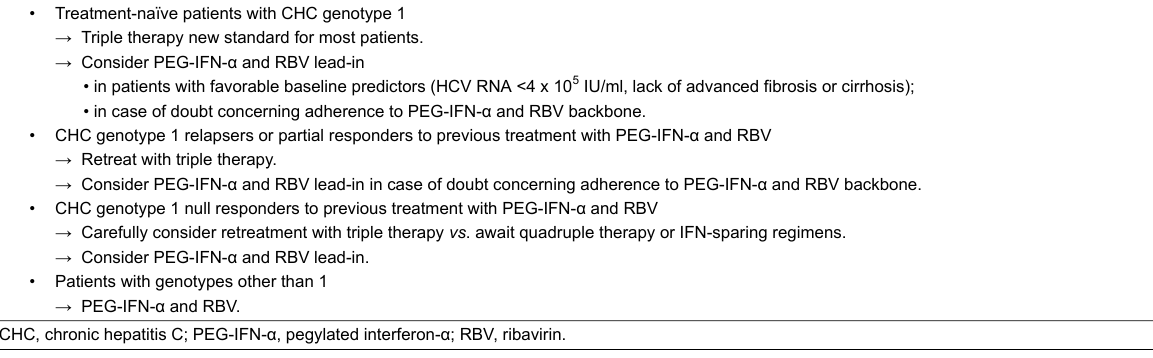
Table 2: Who should be treated with triple therapy comprising telaprevir (TPV) or boceprevir